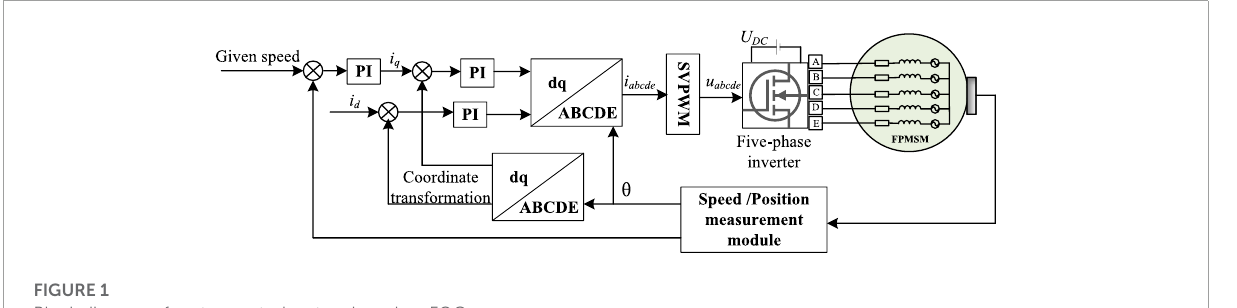
FIGURE 1 Block diagram of motor control system based on